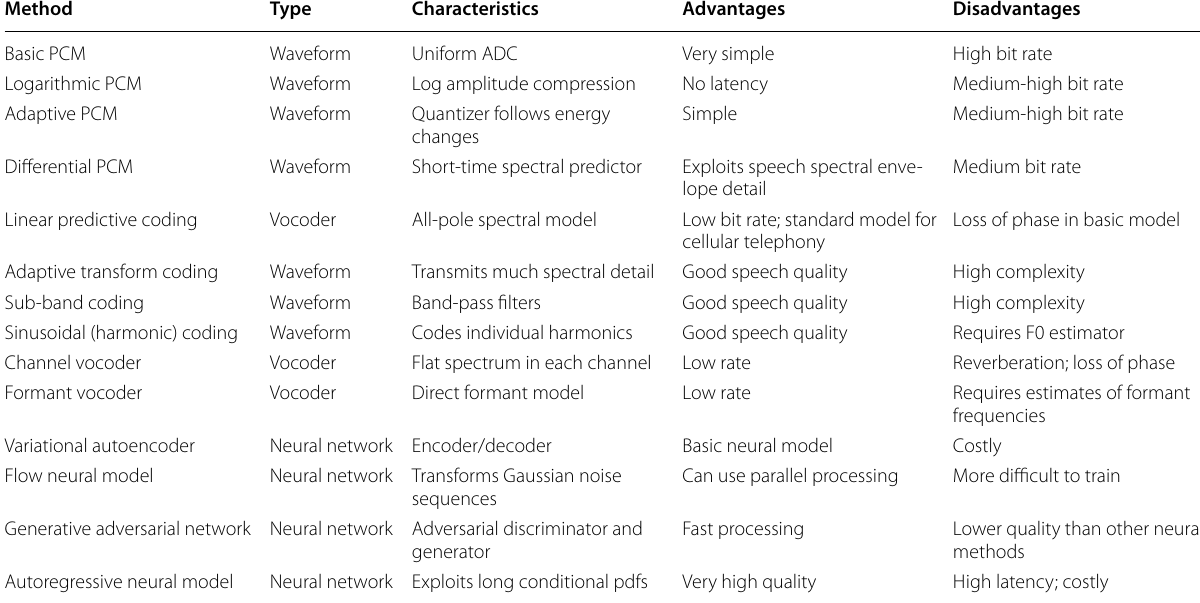
Table 1 Summary of speech coding